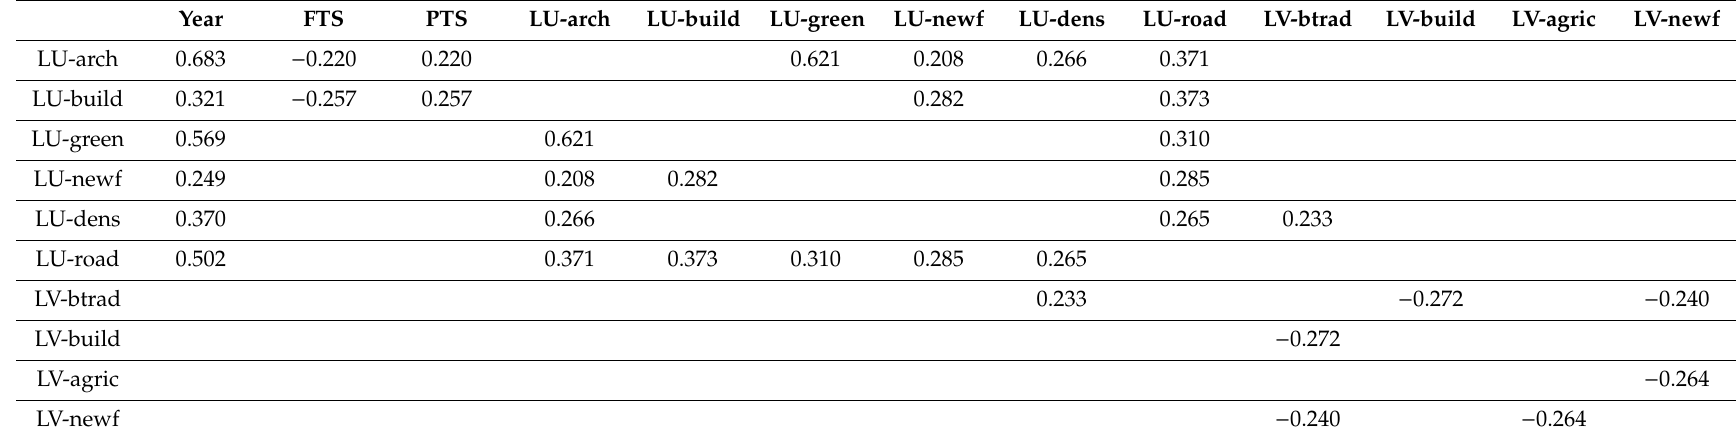
Table 5. Comparison of highly significant correlations ( p > 0.01) between individual characteristics determining the perception of the urban and the rural landscapes (EnvEng and CivEng students combined, n =